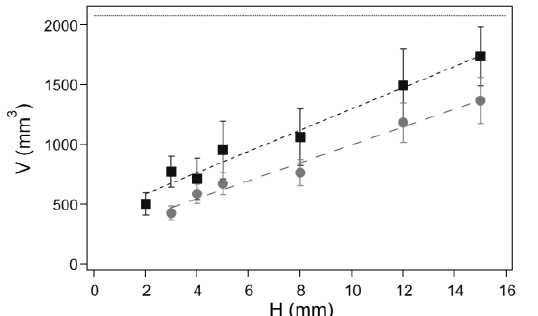
Fig. 6. Volume of hydrogels reached at end time as a function of H cell aperture. ■ individual growth experiments, ● collective growth experiments. In dotted line, the value for the hydrogel without confinement. The bars represent the measurement error that comes from the propagation of errors in the volume measurement of equations (1) to